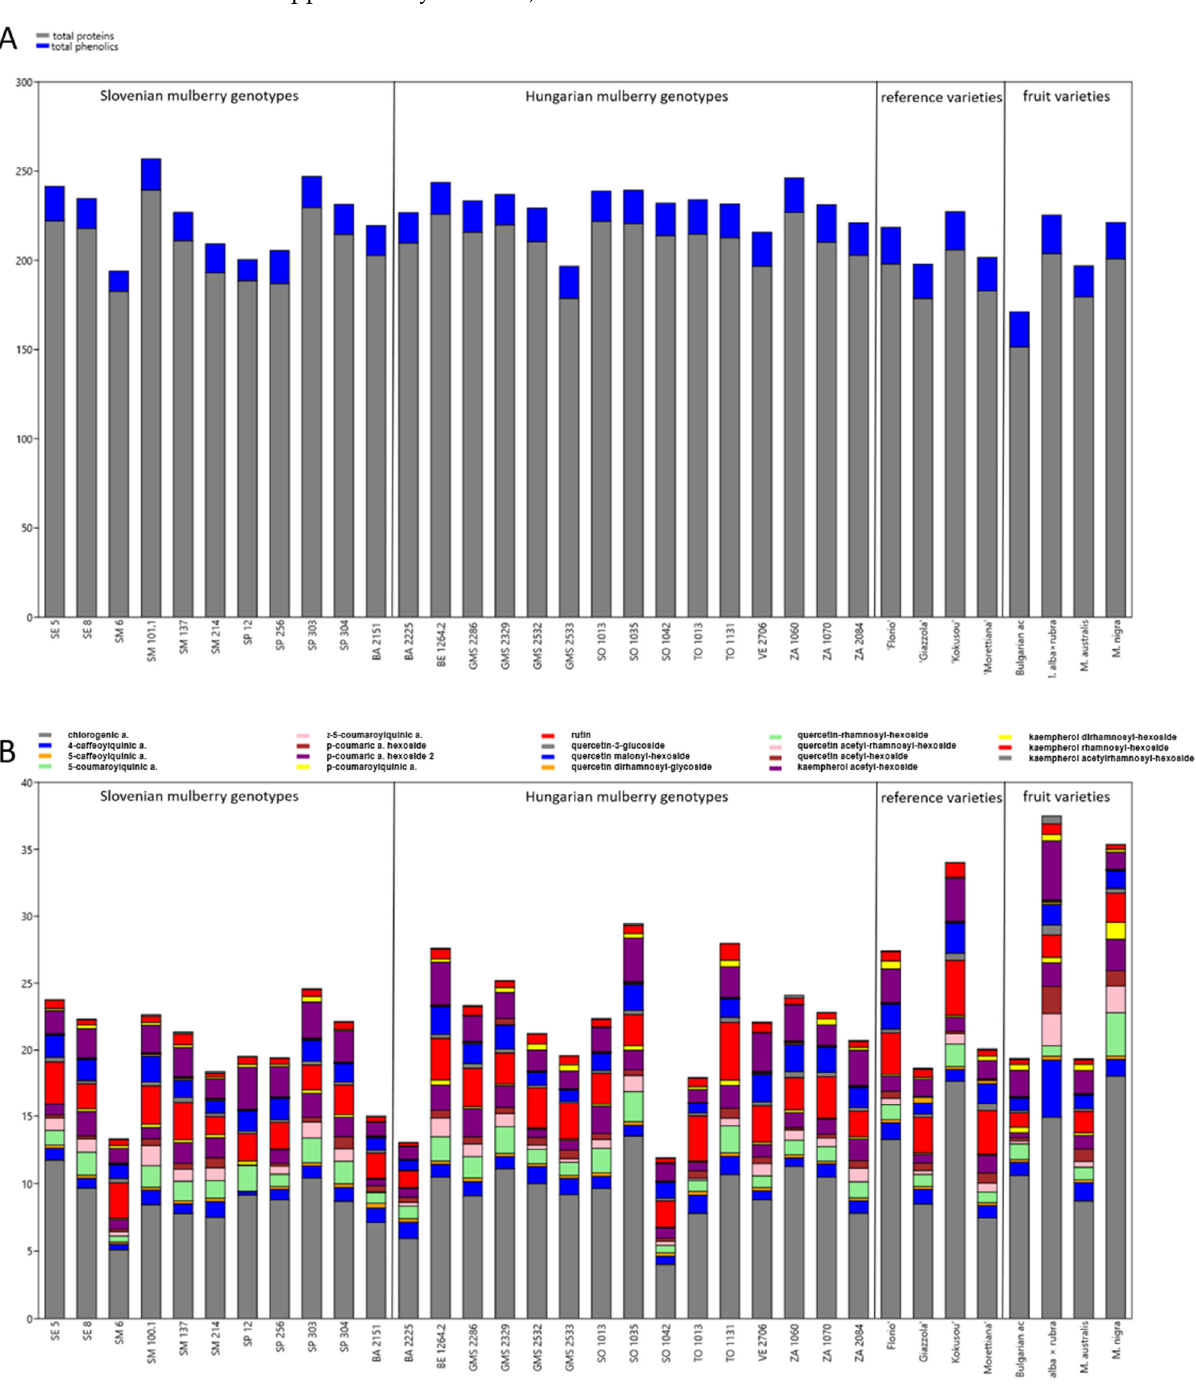
Figure 1. The mean concentrations of the ( A ) total proteins and total phenolics (mg/g DW), and ( B ) the concentrations of individual phenolics (mg/g DW) in leaves of Slovenian, Hungarian old mulberry genotypes, reference sericultural, and fruit varieties. For detailed data and statistics see Table 1 and Supplementary Table S2.